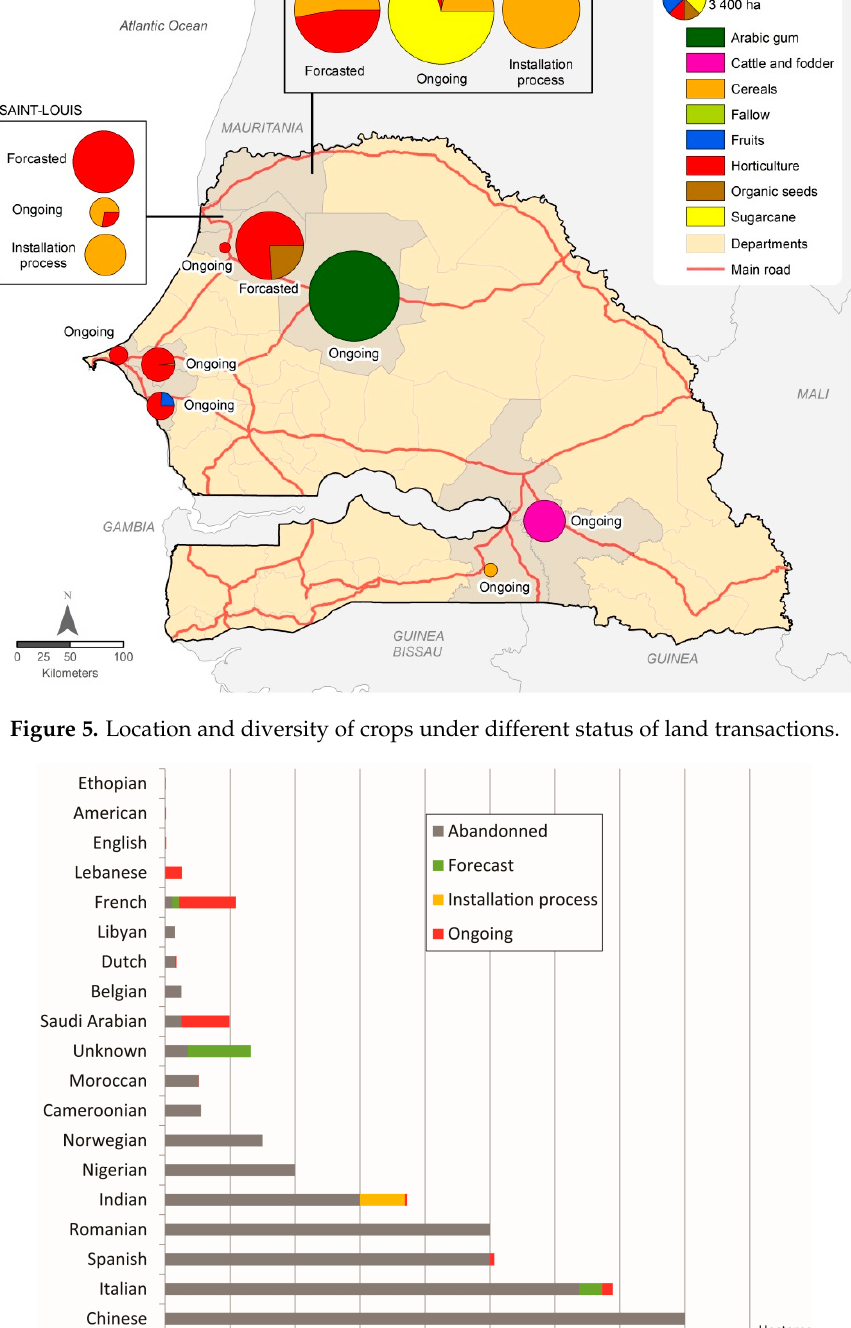
Figure 6. Nationality of agribusiness and status of land transactions.